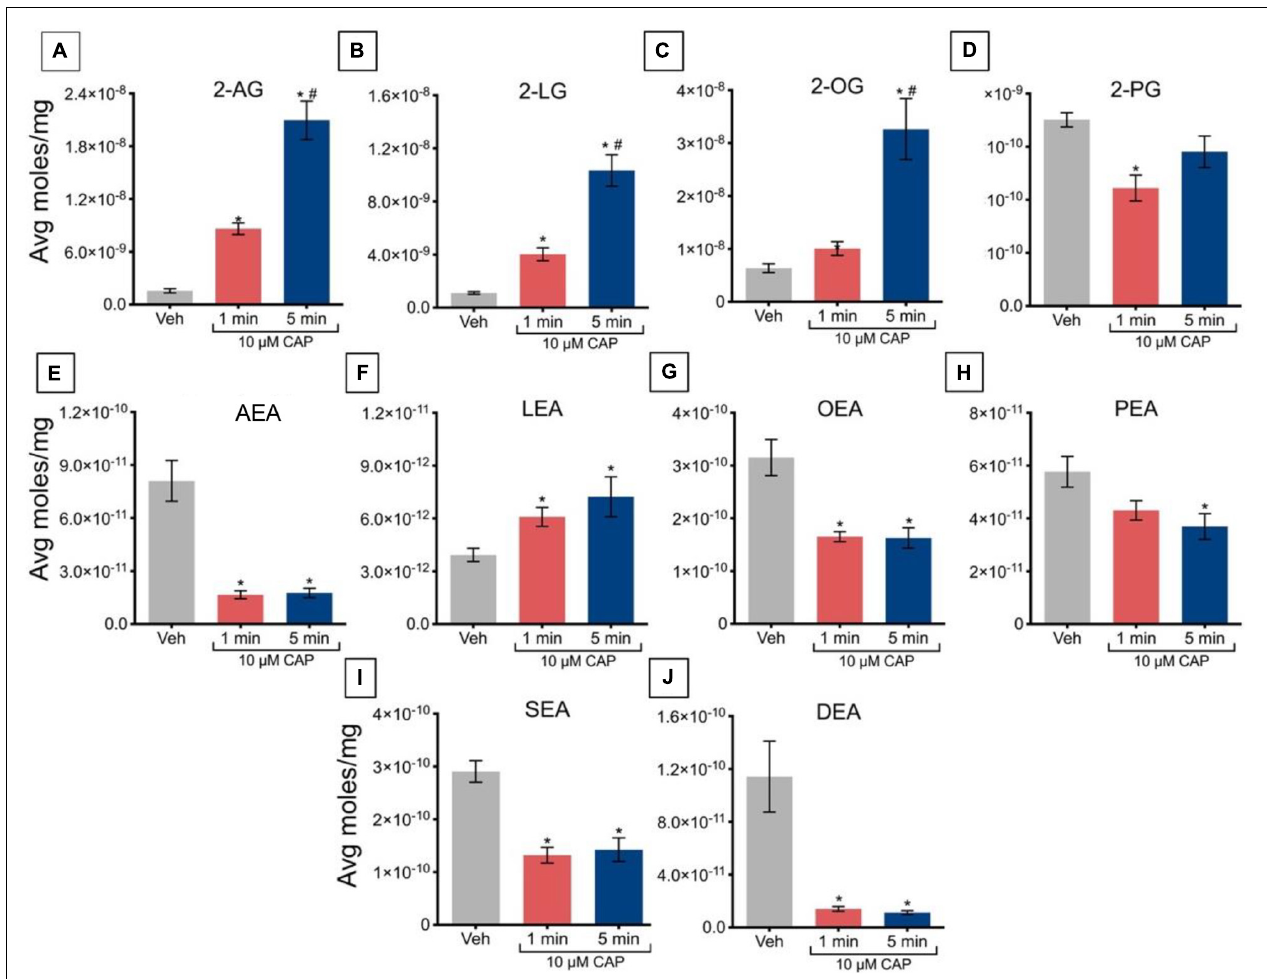
FIGURE 3 | Changes in lipid levels of 2-acyl glycerols (A–D) N -acyl ethanolamines (E–J) after TRPV1-HEK293 cells incubated in 10 µ M capsaicin (CAP) for either 1 min or 5 min. Significant changes in lipid levels when comparing capsaicin-induced changes after 1 min or 5 min to vehicle is indicated by * ( p ≤ 0.05). Significant changes in lipid levels when comparing capsaicin-induced changes after 1 min of incubation vs. 5 min of incubation is indicated by # ( p ≤ 0.05). Data depicted in each graph were averaged over 16 total data points per condition ( n = 4 individual experiments) and presented as average moles/mg ( y -axis).